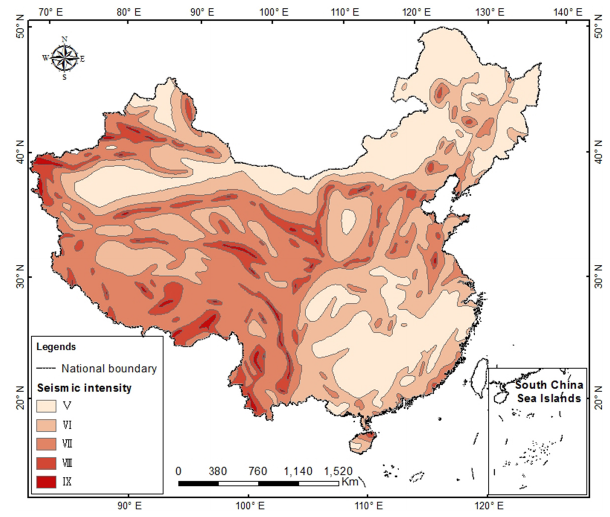
Figure 3. Earthquake intensity zoning map of China (third genera- tion) (adapted from China Earthquake Administration,